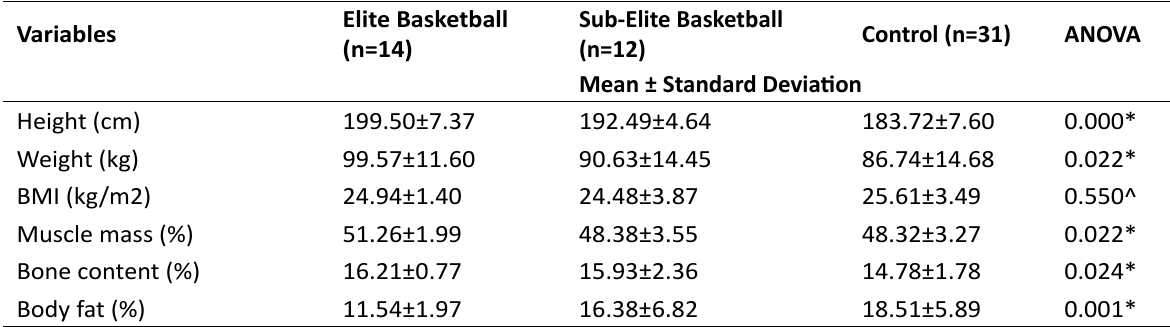
Table 1. Descriptive data and ANOVA of male athletes enrolled in the study (n=57)